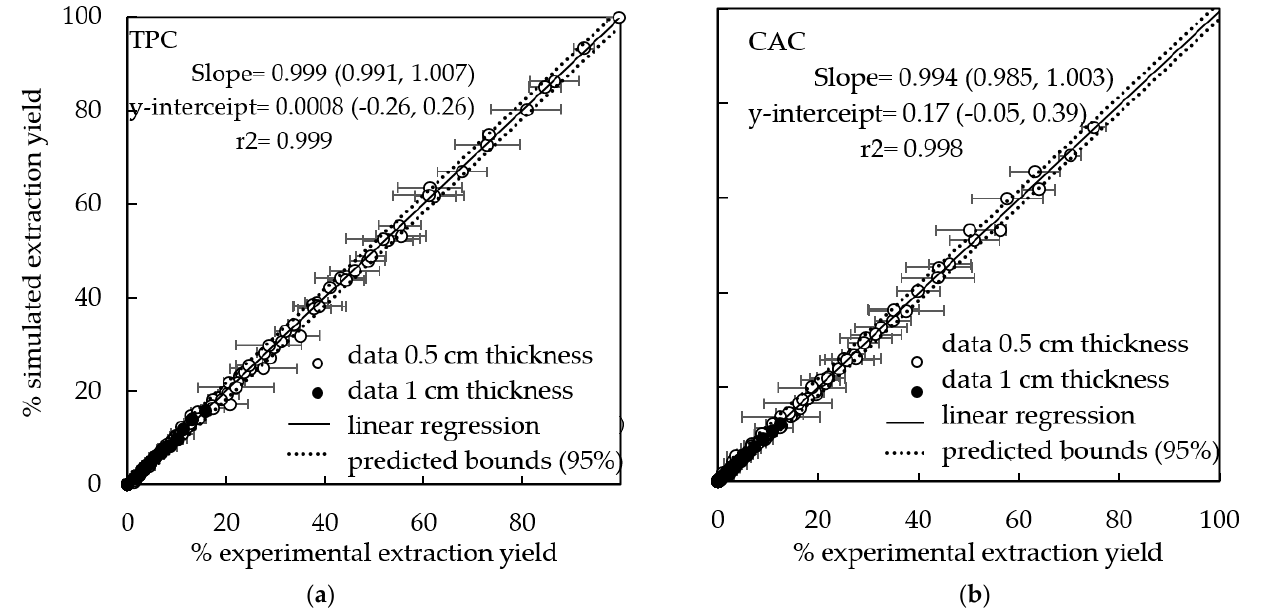
Figure 3. Simulated vs. experimental ( a ) total polyphenol content (TPC) and ( b ) chlorogenic acid content (CAC) extraction yields from artichoke stem, linear regression (slope and y-intercept), and predicted bounds at 95% of confidence. Experiments carried out with slabs of 0.5 cm thickness at different temperatures (25, 40 and 60 °C) with agitation (100 rpm) and acoustic assistance (200 W/L and 335 W/L) and with slabs of 1 cm thickness at 40 °C with agitation (100 rpm) and acoustic assistance at 200 W/L.